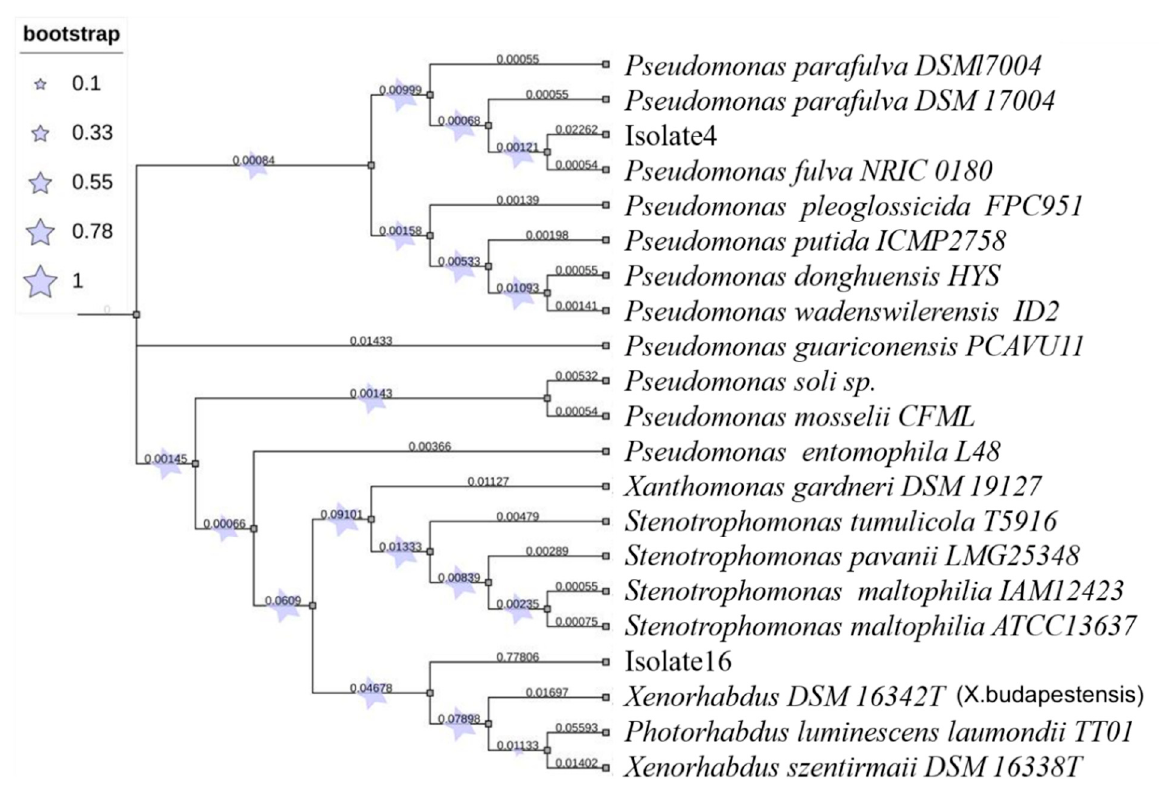
Figure 1. Phylogenetic tree representing distances based on the 16S rRNA sequences acquired from isolates within insect pathogenic nematodes that infected pomegranate plants.